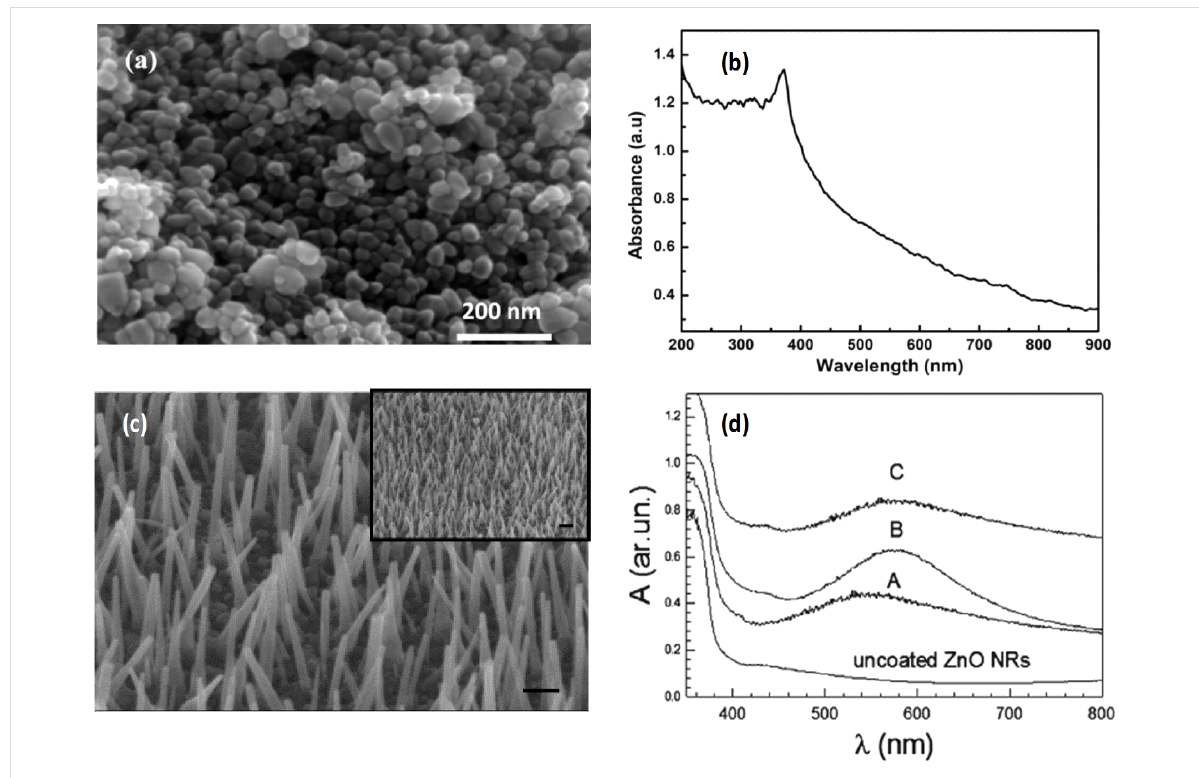
Figure 1: SEM of hydrothermally grown ZnO nanoparticles (a) and of vertically aligned ZnO nanords (c). UV–vis absorption spectra of spherical ZnO nanoparticles (b) and of ZnO nanorods coated with Au at different sputtering time: 20 s (sample A), 30 s (sample B), and 60 s (sample C) (d). Figure 1 (a) and (b) were reproduced from [8] (B. P. Majee et al., “Bi-functional ZnO nanoparticles as a reusable SERS substrate for nano-molar detection of organic pollutants”, Mater. Res. Express, vol. 6, article no. 1250j1, published on 7 February 2020; https://doi.org/10.1088/2053-1591/ab6f31); ©